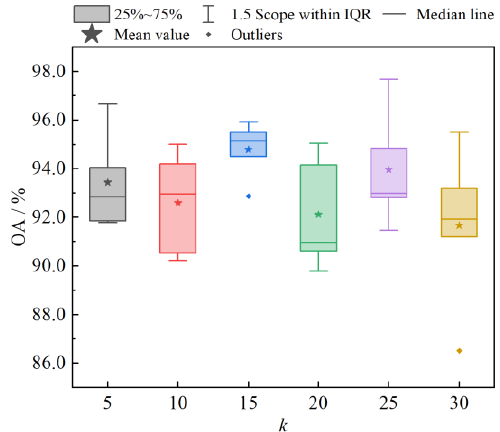
Figure 6. Box plots of OA with different numbers of neighborhood nodes k .